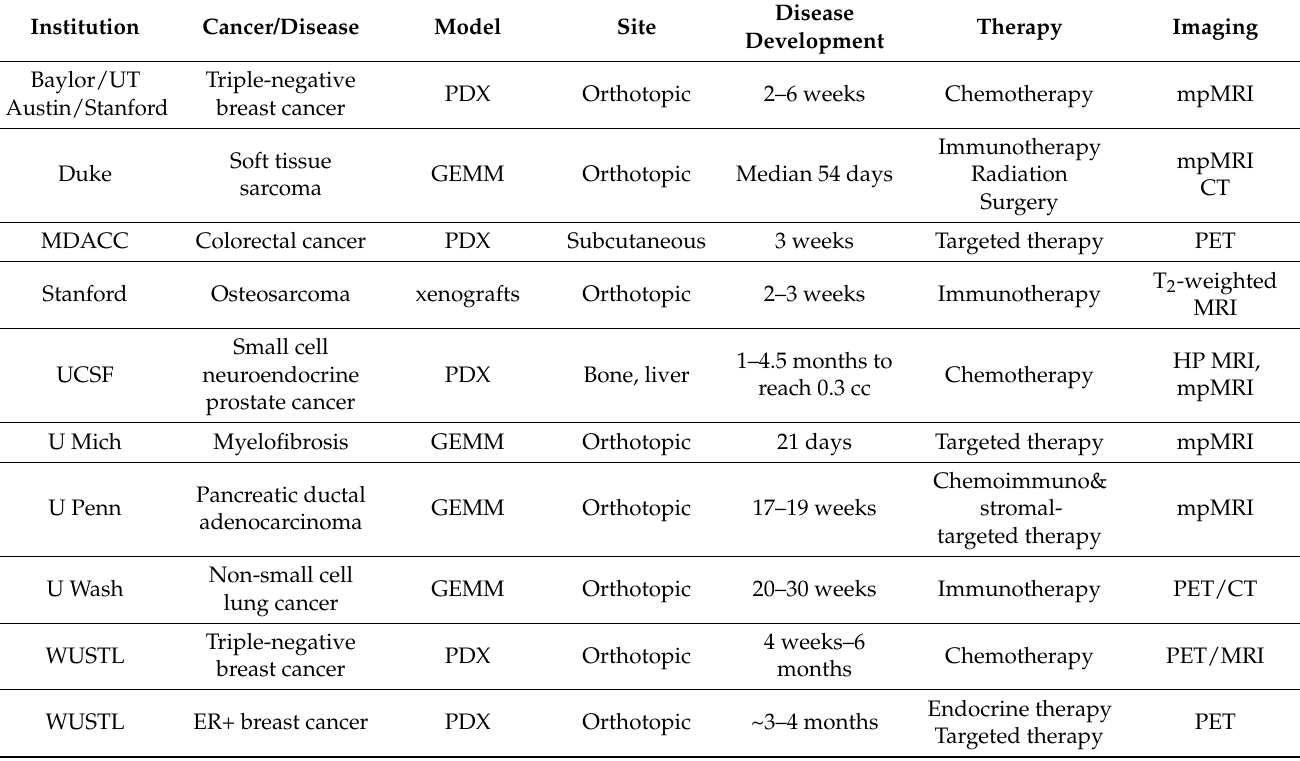
Table 1. Overview of projects in the AMCT WG of the CIRP